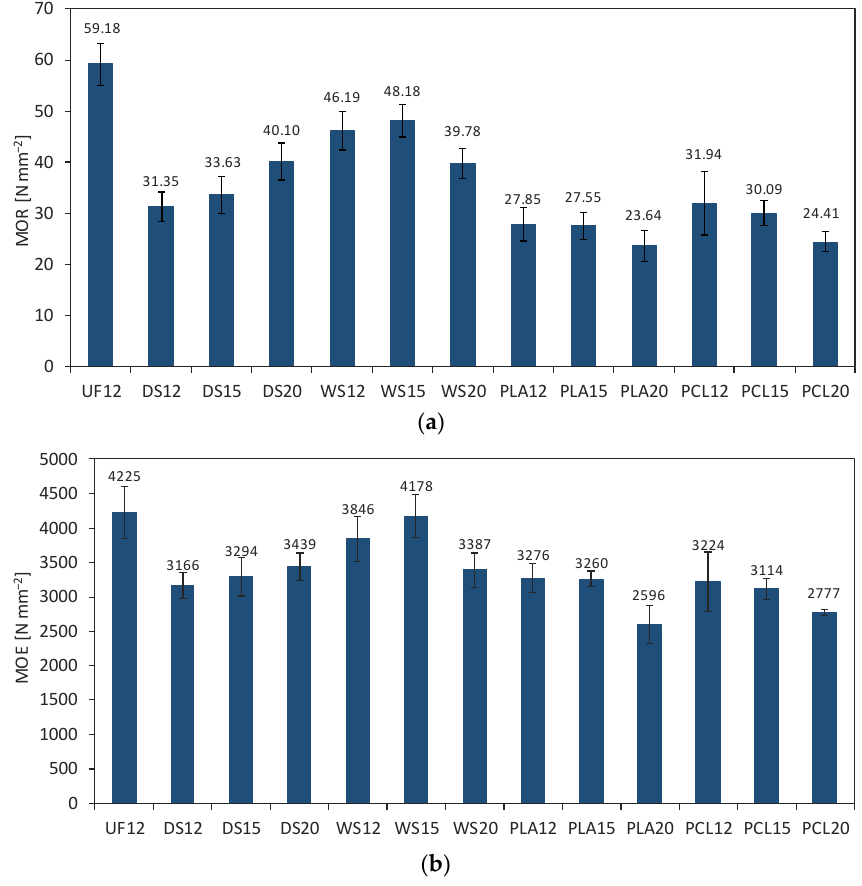
Figure 3. ( a ) Modulus of rupture (MOR) and ( b ) modulus of elasticity (MOE) of tested HDF.